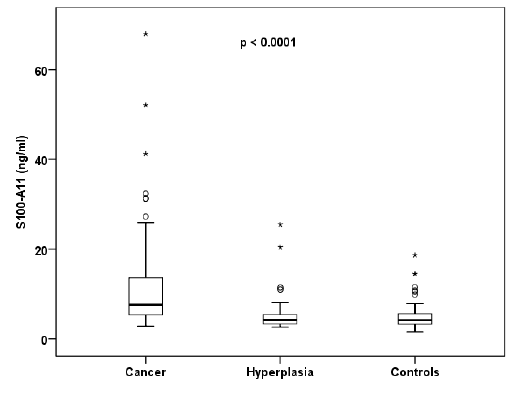
Figure 1: TFF3 serum levels in endometrial cancer (cancer, n=98), endometrial hyperplasia (hyperplasia, n=43), and normal endometrium (controls, n=91) patients.